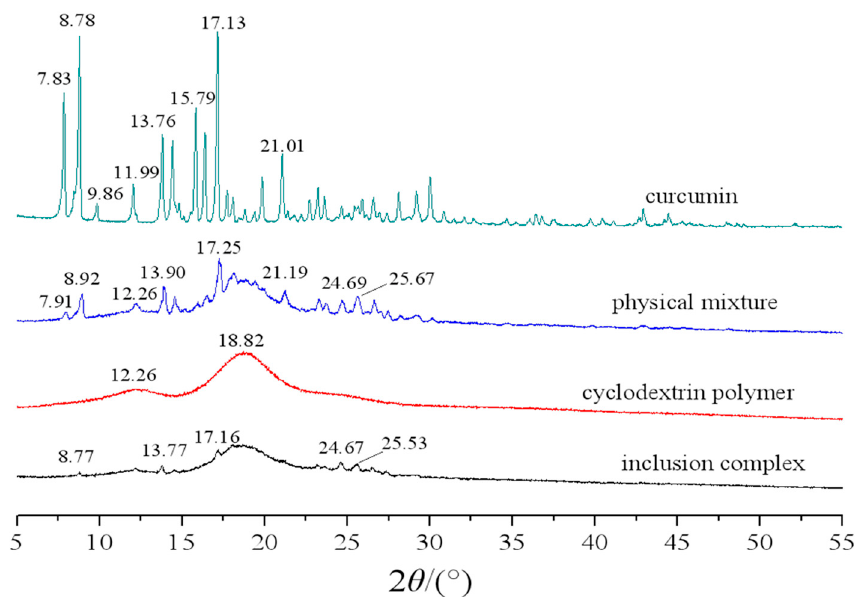
Figure 1. Powder X-ray diffraction patterns of curcumin, curcumin and cyclodextrin polymer physical mixture, cyclodextrin polymer, and curcumin/cyclodextrin polymer inclusion complex.